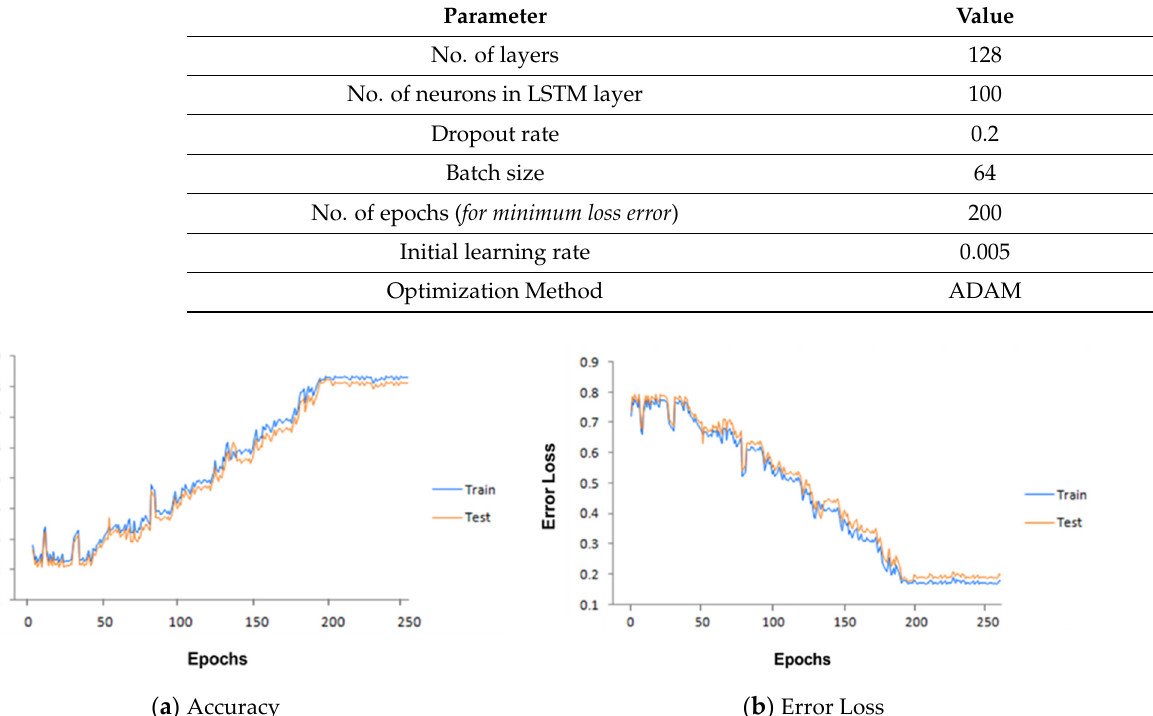
Figure 4. Our Bi-LSTM model performance as epochs increase.